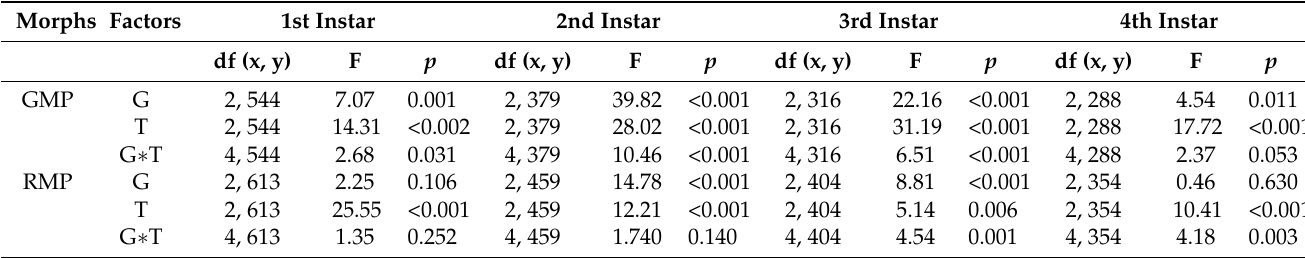
Table 3. Two-way ANOVA for the effects of growth periods (G) and treatments (T) on different instars of green color morphs of pea aphids (GMP) and red color morphs (RMP) of pea aphids. Morphs